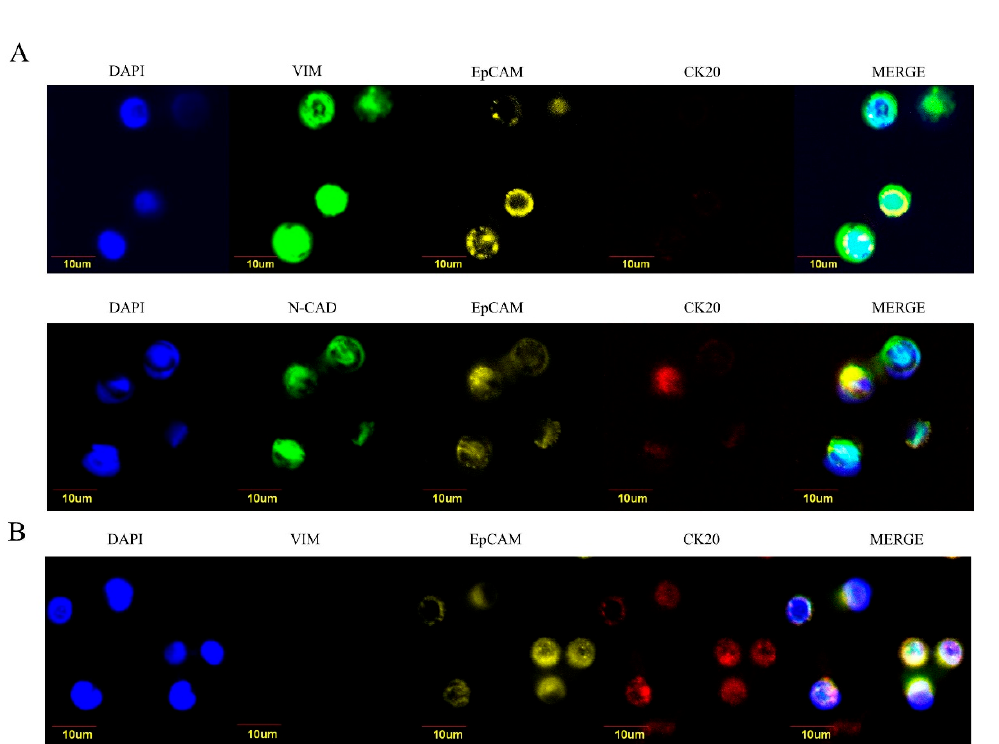
Figure 3. Epithelial-like and mesenchymal-like CTC isolated from left-sided (panel A ) and right-sided (panel B ) colorectal cancers. Panel A : Epithelial-like CTC analyzed by immunofluorescence for EpCAM (yellow), cytokeratin 20 (CK20, red), and vimentin / N-cadherin (VIM / N-CAD, green). In blue, nuclei are visualized. Original magnification 60 × . Panel B . mesenchymal-like CTC analyzed by immunofluorescence for EpCAM (yellow), cytokeratin 20 (CK20, red), and vimentin (VIM, green). In blue, nuclei are visualized.